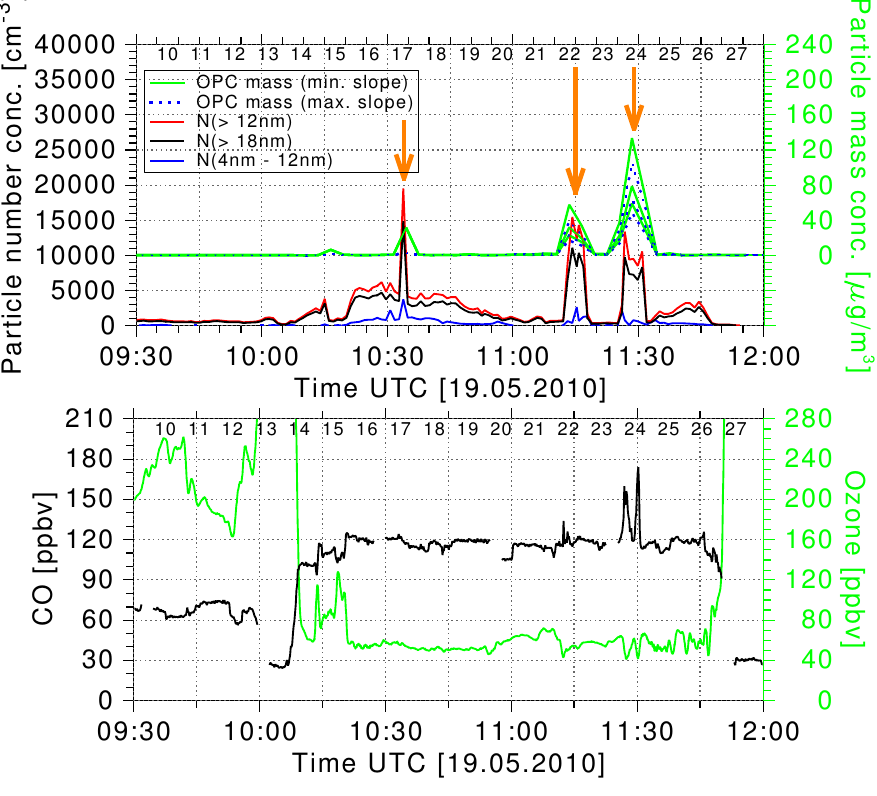
Fig. 7. Measurements from the CARIBIC volcano flight on 19 May 2010 during the volcanic cloud encounter (see arrows). Same represen- tation as in Fig. 5. Additionally, OPC particle mass concentrations for particles larger than 138nm are shown in the upper panel (right scale). The solid green lines show the mass concentration assuming the smallest slope while the dotted blue lines are calculated assuming the largest slope in the size distribution extrapolation. The three lines are calculated assuming different refractive indices for the volcanic ash particles (see